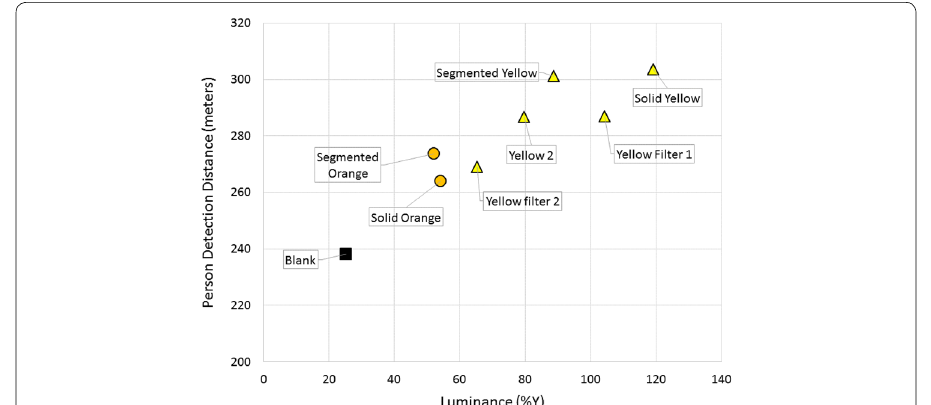
Fig. 4 Scatterplot of mean person detection distance (meters) and luminance (%Y) in Study 1 for lime yellow and orange-red fluorescent trims and a blank control